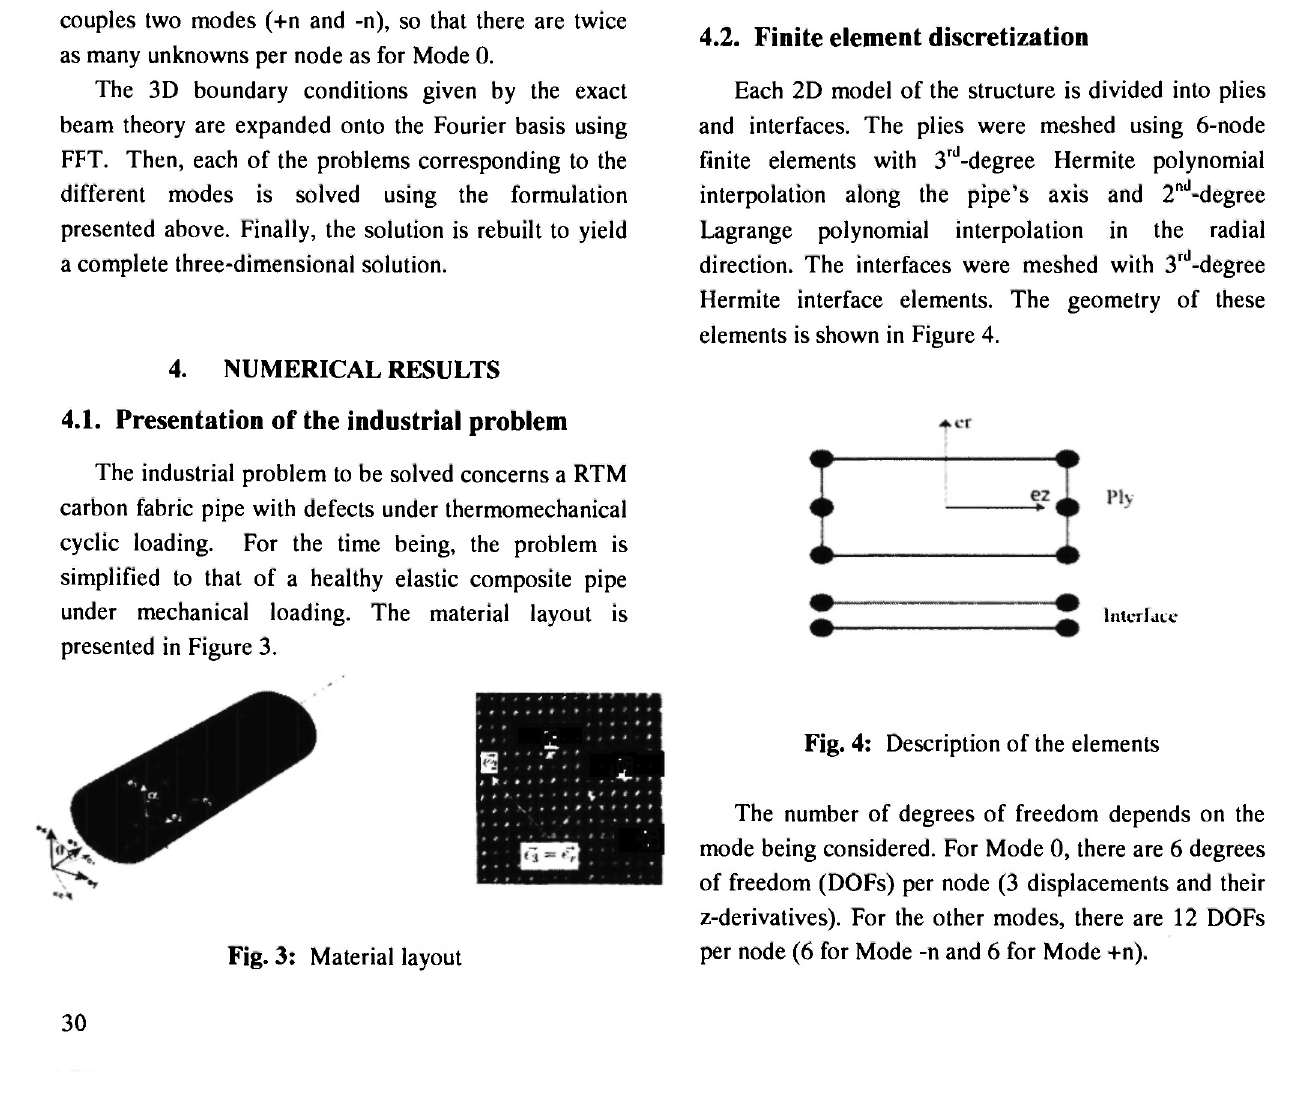
Fig. 3: Material layout